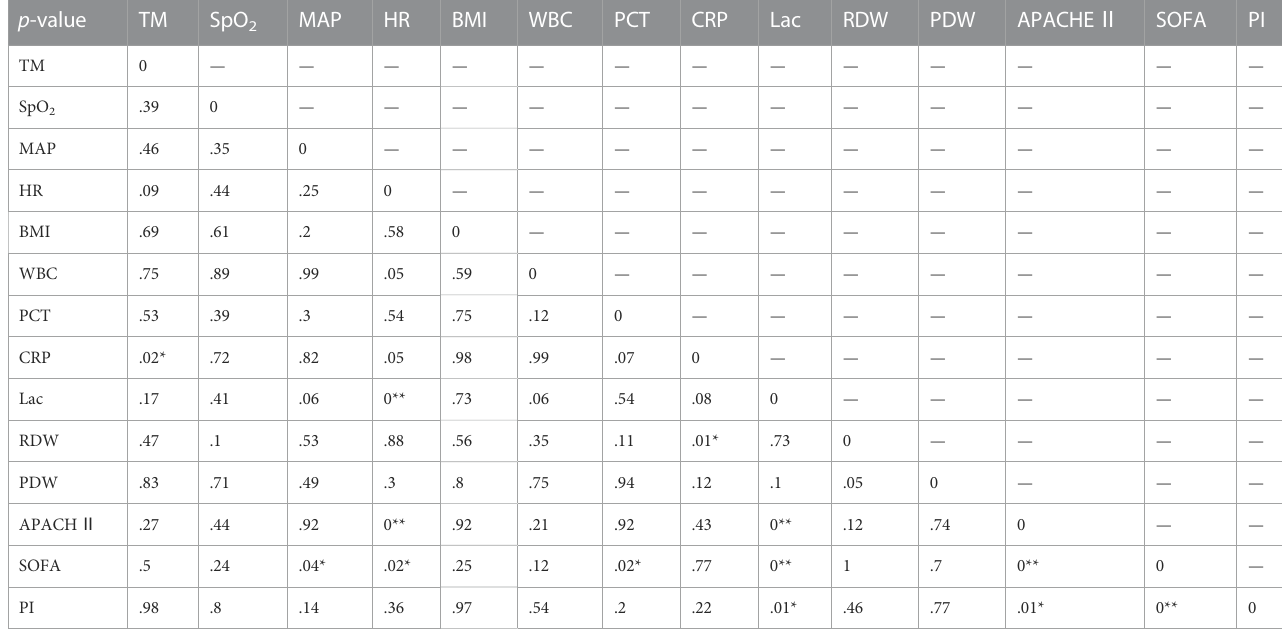
TABLE 2 p -value for the relevance. p -value